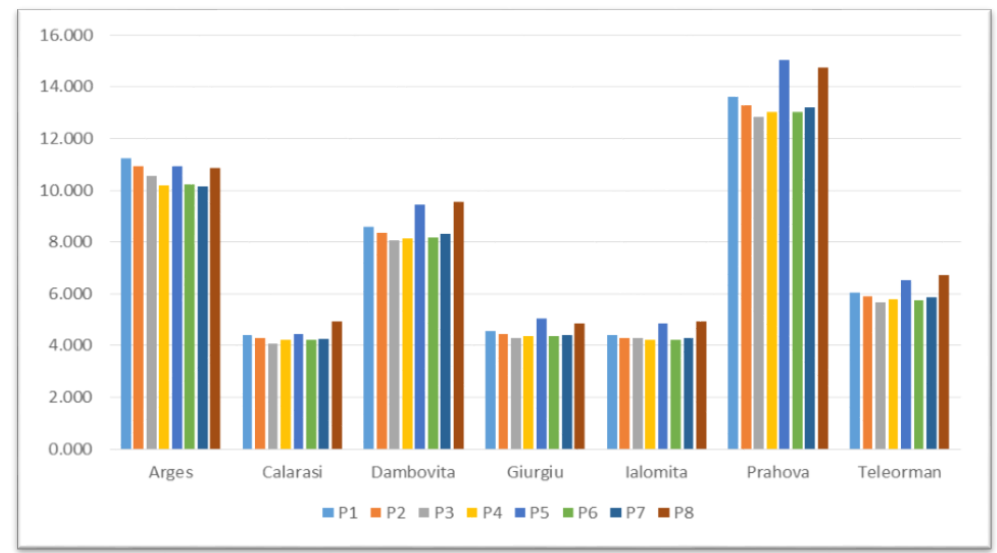
Figure 10. LCC at county level for the average scenario (bln.euro).